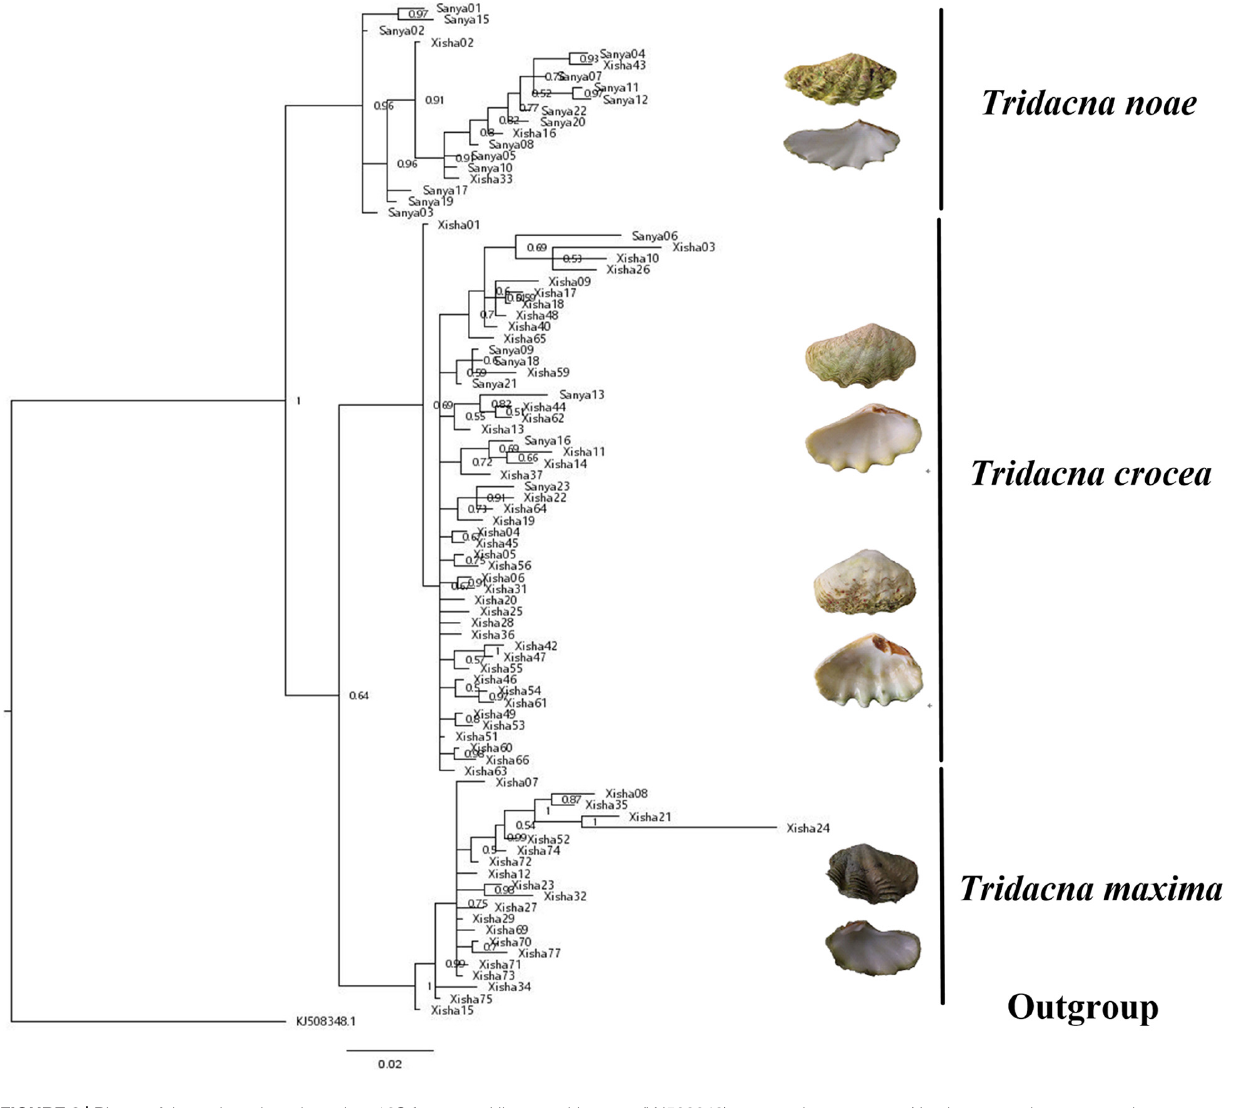
Frontiers in Marine Science |